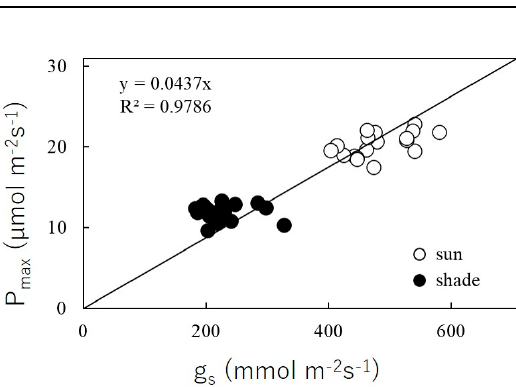
Figure 5. Response of the net photosynthetic rates to intercellular CO 2 concentration for sun and shade leaves of Robinia pseudoacacia . Values represent mean ± SE. Table 2. Estimated parameters of the photosynthetic rate curves for sun and shade leaves of Ro- binia pseudoacacia . Values represent mean (SE in parentheses). ANOVA was used to test the differ- ence between the leaf position at the 0.05 alpha level. Parameter